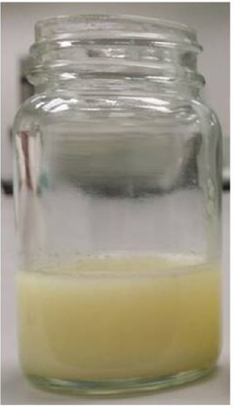
Figure 7. Organogel at room temperature .